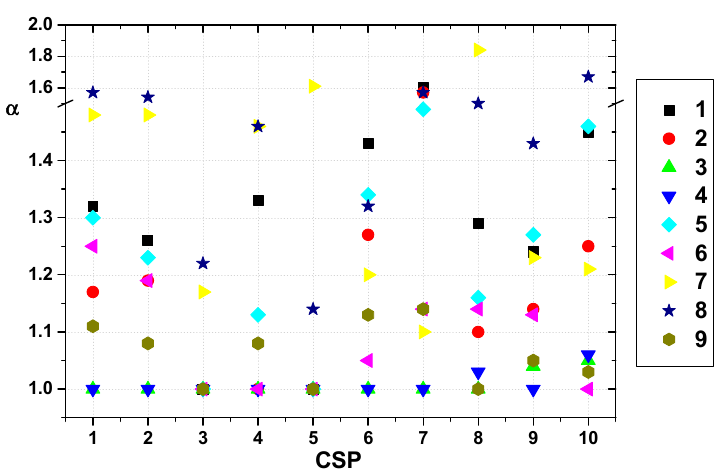
Figure 3. Separation factors of compounds 1 – 9 on prepared CSP-1 – CSP-10 , mobile phase hexane-2-propanol = 90:10. For compound 8 , the mobile phase ratio was 80:20.